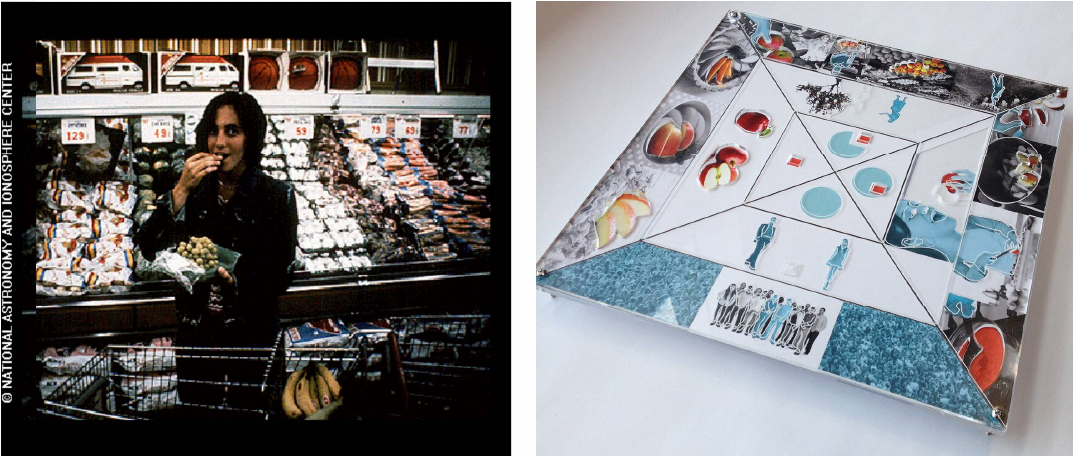
Figure 10. Shows a student redesign ( right ) of the original NASA image ( left ) about food consumption for energy. The redesign attempts to teach its audience an equivalence between the icon and the symbol for person and for food. The device assumes some gestalt laws of belonging may be universal for sentient beings, and uses the knowledge that colour trumps shape.